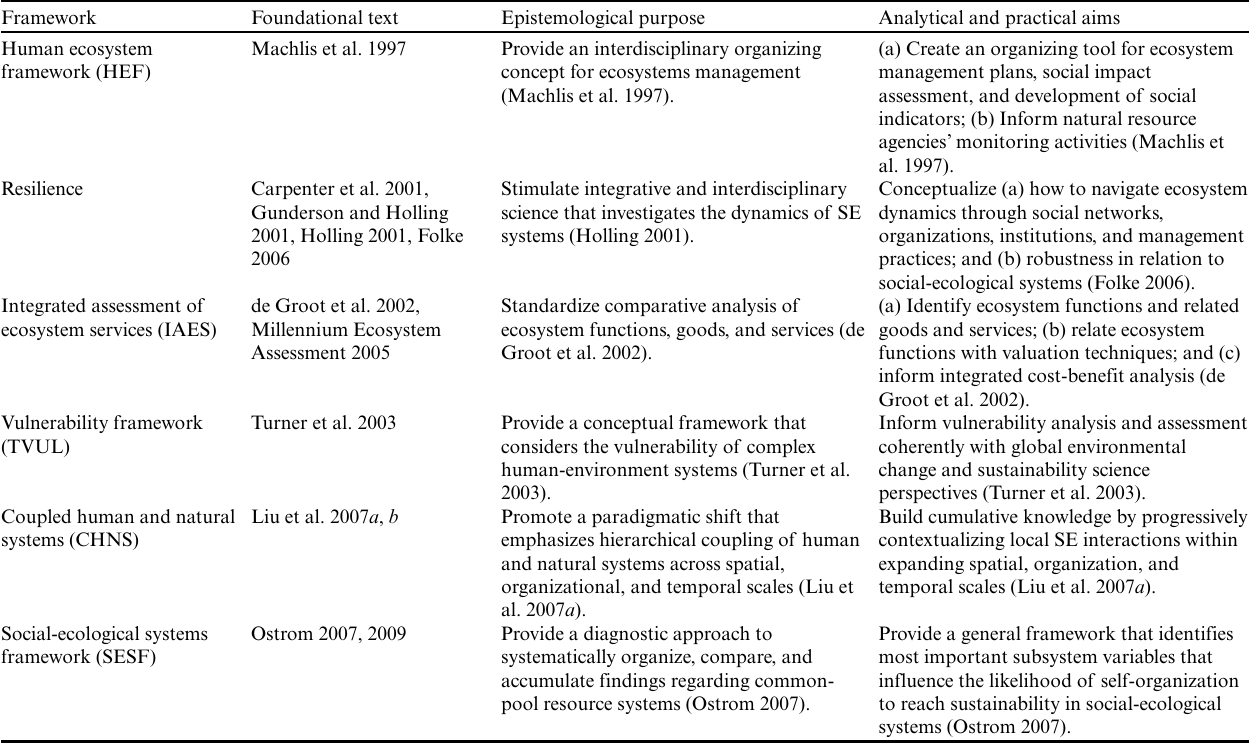
Table 1 . Epistemological purpose and analytical aims of socio-environmental (SE) frameworks